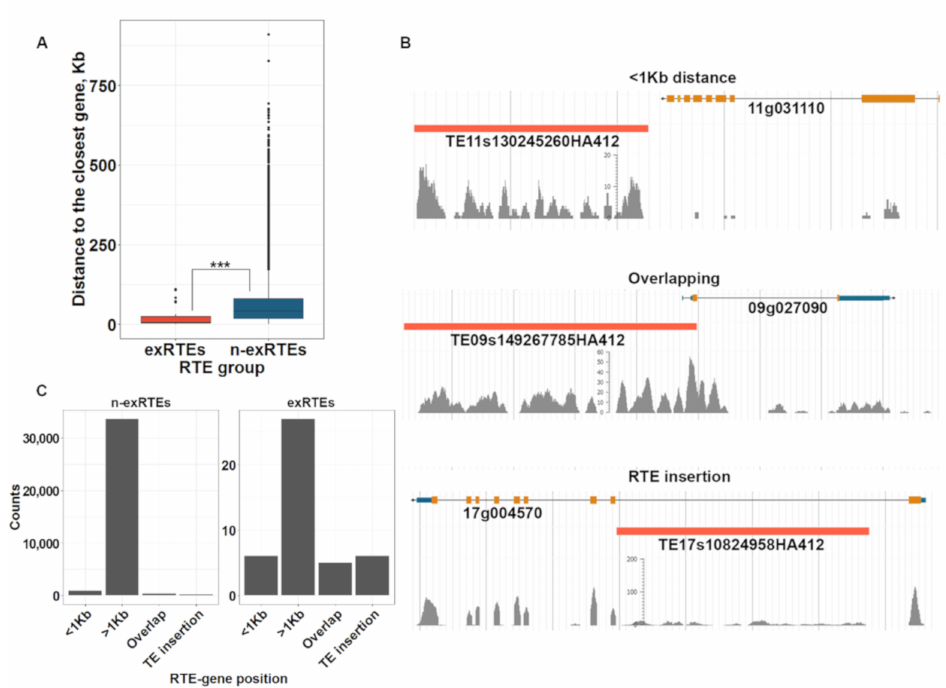
Figure 4. The distance of (n-)exRTEs to the adjacent genes. ( A ): Box plot of the distance (kb) to the closest genes for exRTEs and n-exRTEs. ( B ): Examples of exRTEs and their proximity to the closest genes. Three stars indicate significant di ff erences based on Wilcoxon rank sum test p -value < 0.001 ( C ): Bar plot showing the number of (n-)exRTEs with di ff erent distances to the closest